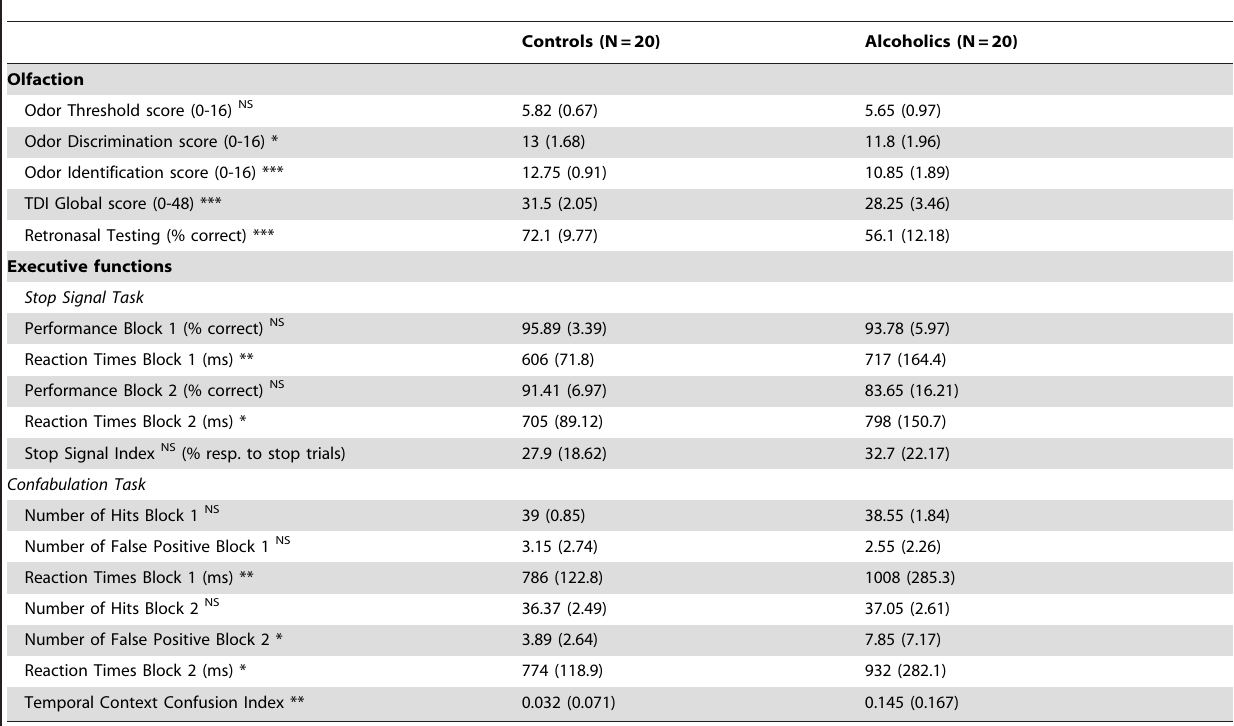
Table 2. Alcoholic and controls individuals’ results for experimental measures: mean (S.D.).